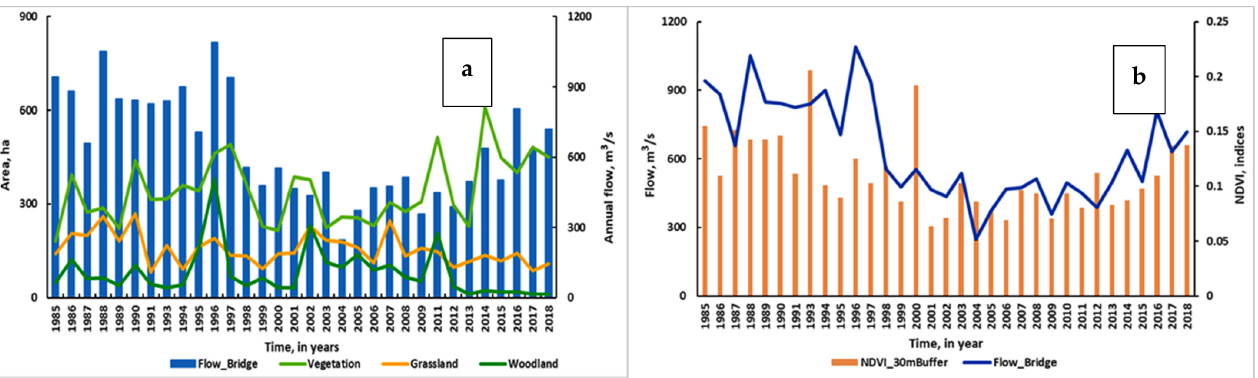
Figure 10. Flow versus vegetation change relationships in the Gumara River; ( a ) flow of Gumara river and riparian vegetation cover between 1985 to 2018, and ( b ) flow of Gumara river and NDVI of 30 m buffer distance from the river between 1985 to 2018.